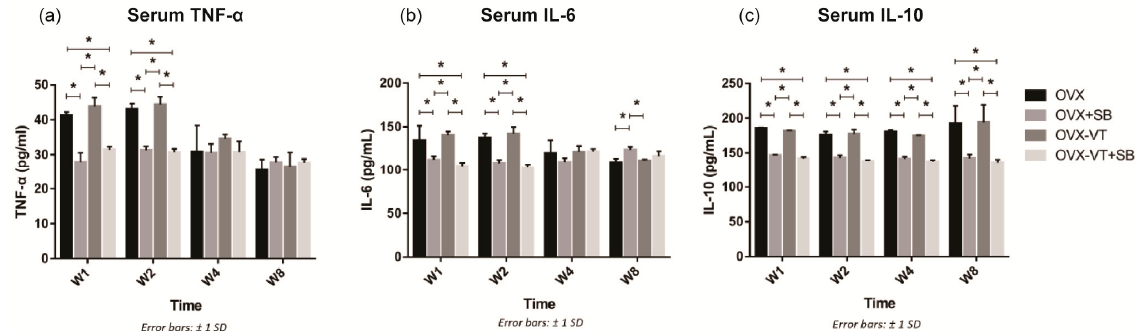
Figure 5. Systemic inflammatory cytokine levels. ( a ) Significantly higher TNF- α levels were detected in the OVX and OVX-VT groups compared to the OVX+SB and OVX-VT+SB groups at weeks 1 and 2. ( b ) The OVX and OVX-VT groups showed significantly higher IL-6 level than the OVX+SB and OVX-VT+SB groups at weeks 1 and 2 (* p < 0.0005 for all). The OVX+SB group demonstrated higher IL-6 level compared to the OVX and OVX-VT groups at week 8. ( c ) Significantly higher IL-10 levels were detected in the OVX and OVX-VT groups compared to the OVX+SB and OVX-VT+SB groups at all time points. * p < 0.0005 for all, one-way ANOVA with post-hoc Bonferroni test. Abbreviation: W: week.